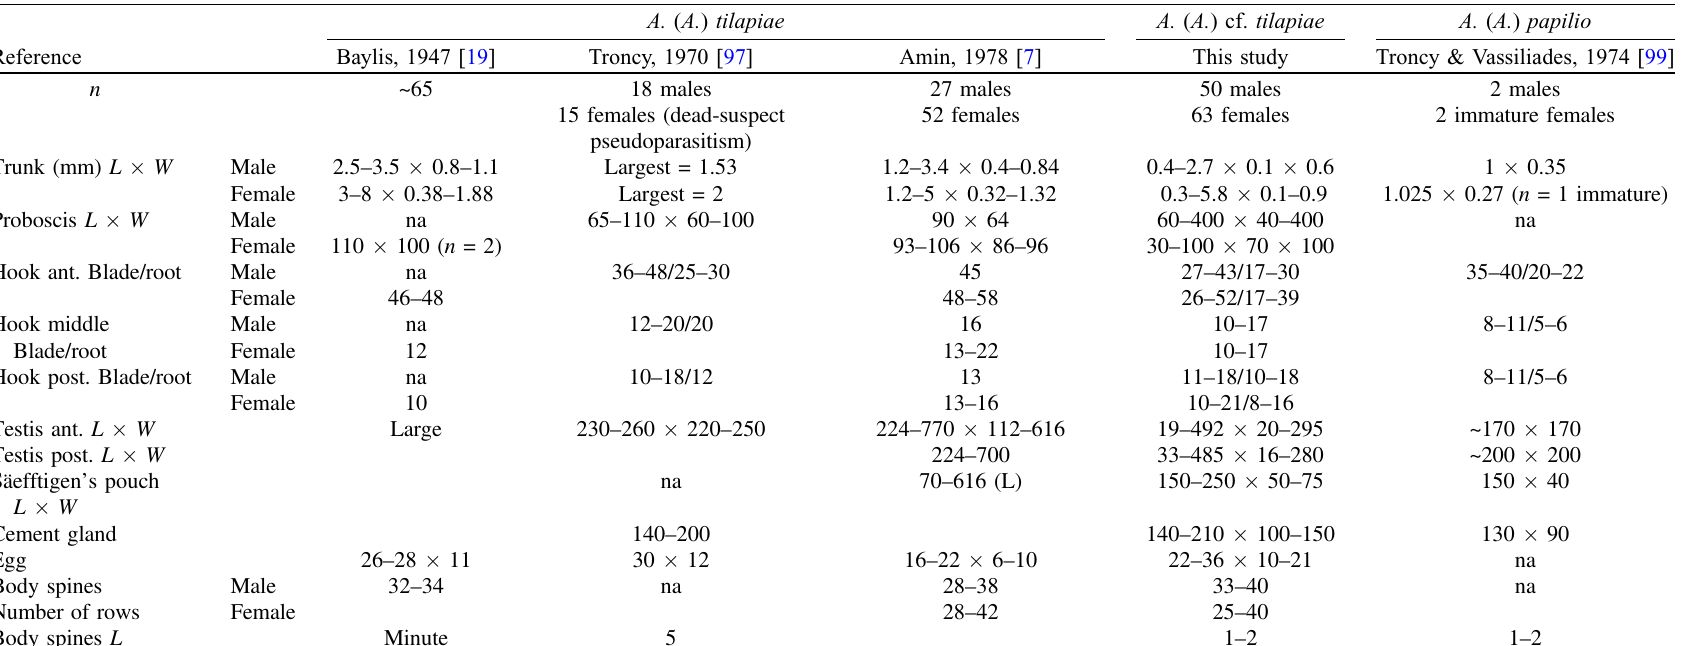
Table 3. Measurements of main morphological characters of specimens of Acanthogyrus ( Acanthosentis ) tilapiae described by Baylis, 1947 [19] and redescribed by Troncy, 1970 [97] and Amin, 1978 [7], A. ( A. ) papilio described by Troncy and Vassiliades, 1974 [97], and specimens (all stages of maturity combined) from this study collected from Coptodon guineensis at Sebkha Imlili. n = number of specimens studied. na = no data available. Merged data indicate no precision for male or female. L = length. W = width. All measurements are in l m unless indicated